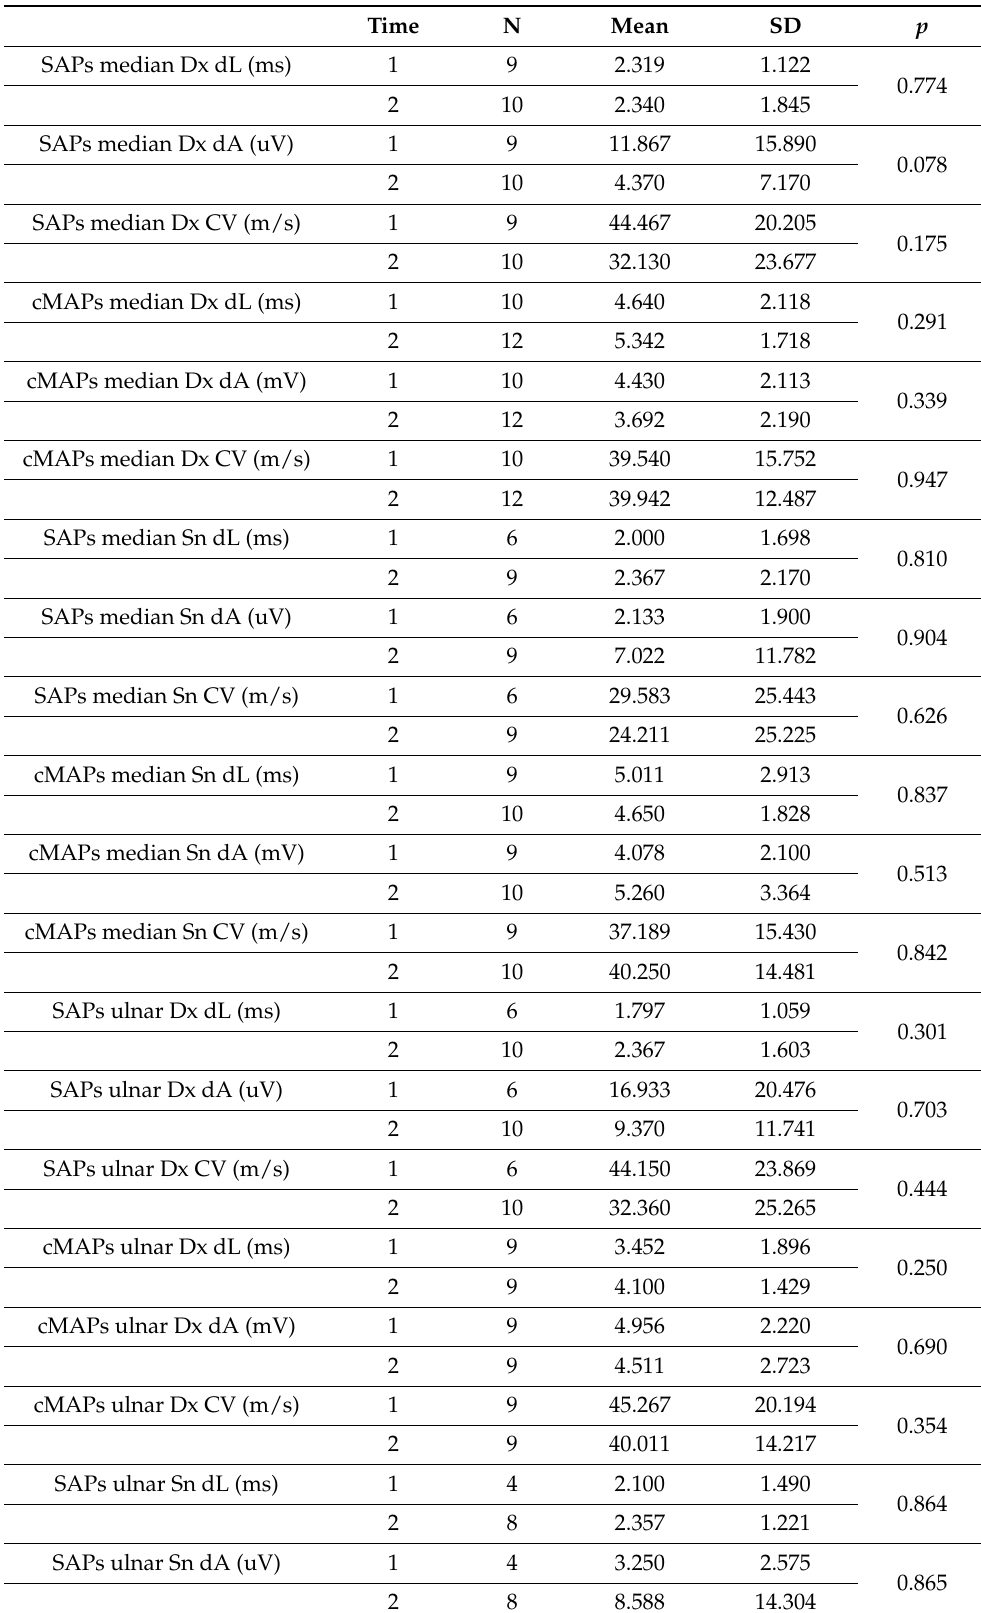
Table 2. Electrophysiological data. Time 1: pre-SCIg; time 2: during SCIg; N: number of patients; Dx: right nerve; Sn: left nerve; dL: distal latency; dA: distal amplitude; SAP: sensory action potential; cMAP: compound motor action potential; CV: conduction velocity; SD: standard